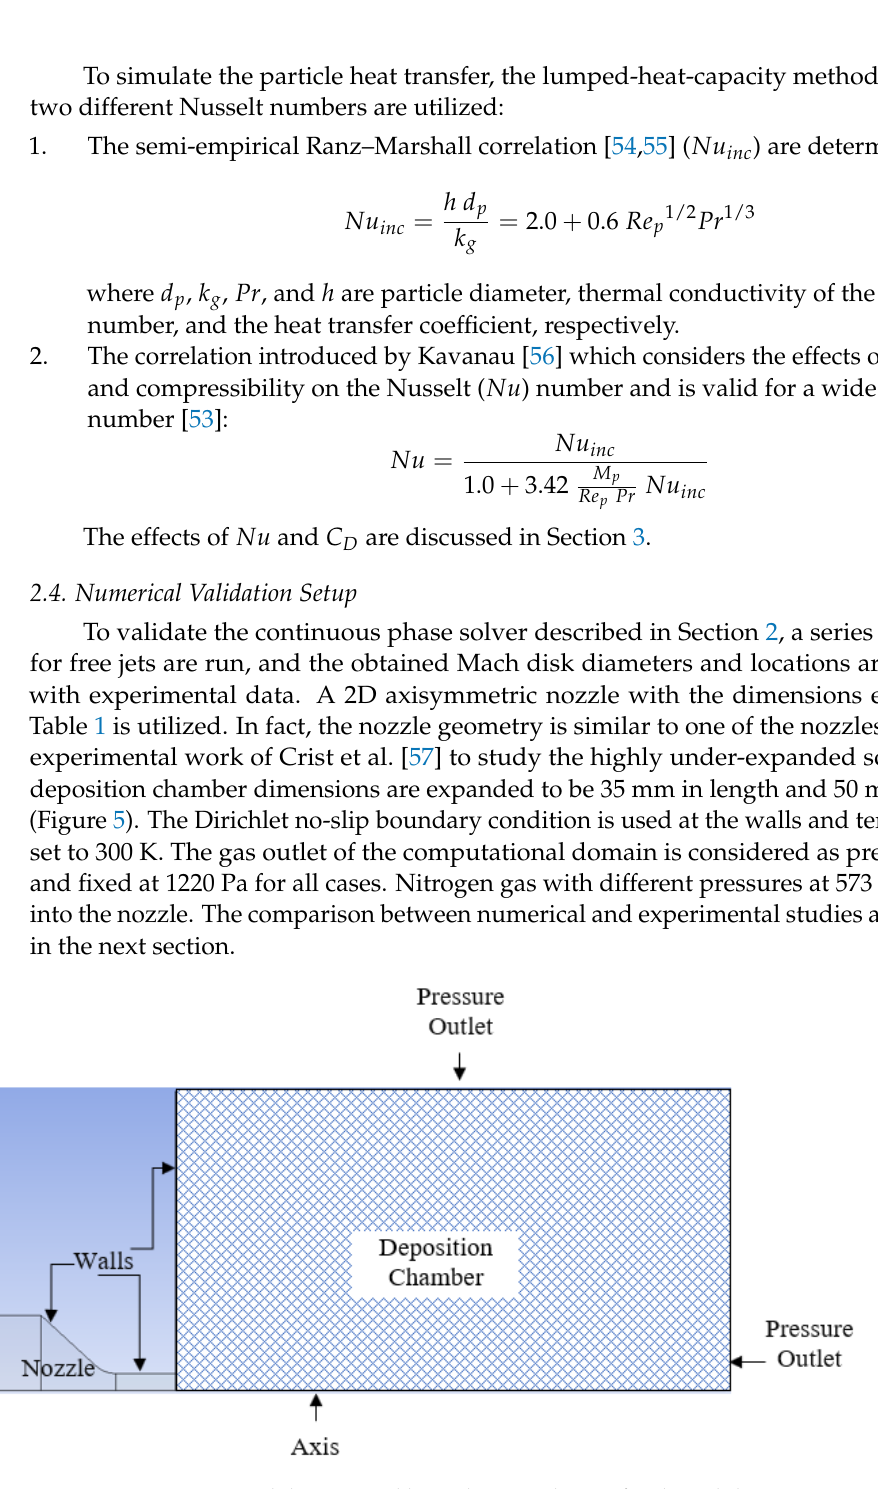
Figure 5. Computational domain and boundary conditions for the validation case .